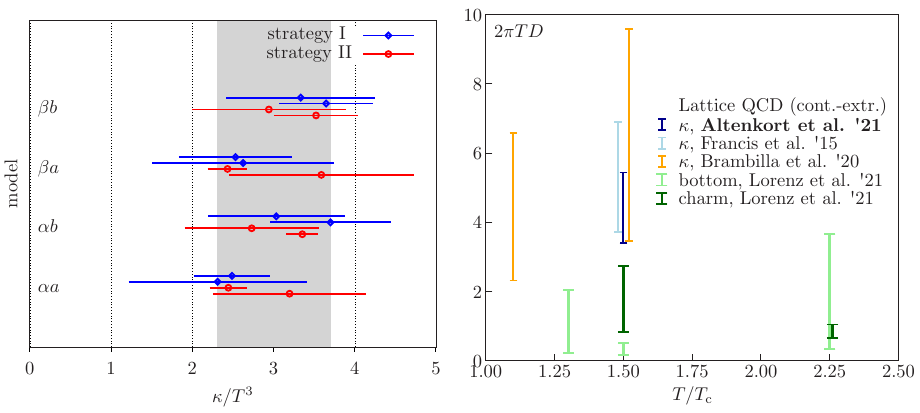
Figure 1. Left: Model correlators obtained from integration of the model spectral functions. The labels Figure 2. Left: Heavy quark momentum di ff usion coe ffi cient κ/ T 3 from all considered spectral function distinguish between di ff erent models (see Eq. (4)). Right: Model spectral functions from fits of the model fits. The grey band indicates the final range we cite (see Section 3). Right: Comparison of the correlator data for all considered models. Statistical errors are hidden for better visibility; for ω = 0 heavy quark spatial di ff usion coe ffi cient 2 π TD from di ff erent studies [12–15]. Results from the heavy they can be found in Fig. 2, all others can be found in the data publication [11]. quark limit using the color-electric correlator (“ κ ” in legend) are converted using D = 2 T 2 /κ . Also shown are recent results obtained from vector meson correlators for charm and bottom